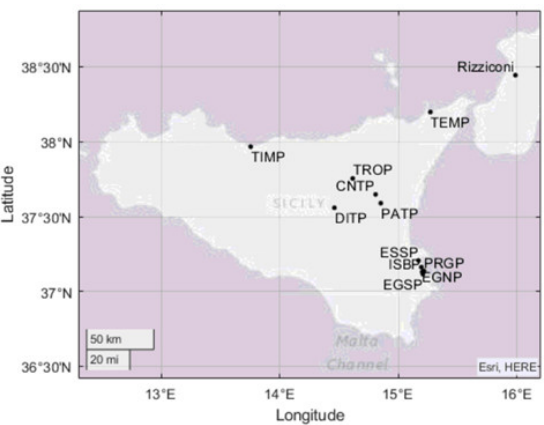
Figure 11. Locations and denominations of the traditional power plants in the Sicilian network.